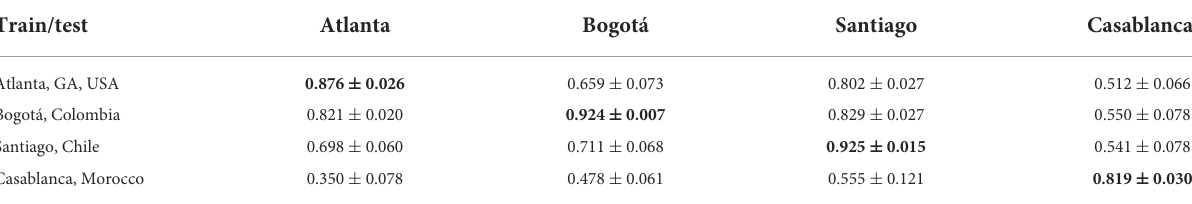
TABLE 4 Performance of classification in terms of ROC-AUC score ( ± standard deviation) with classifier trained on city in row and tested on the city in column, with diagonal showing “native” classifiers. Train/test